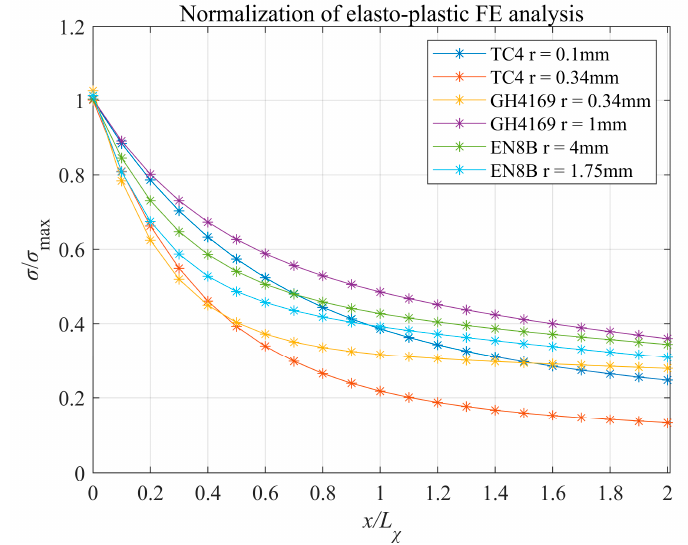
Figure 9. Normalized stress gradient distribution.